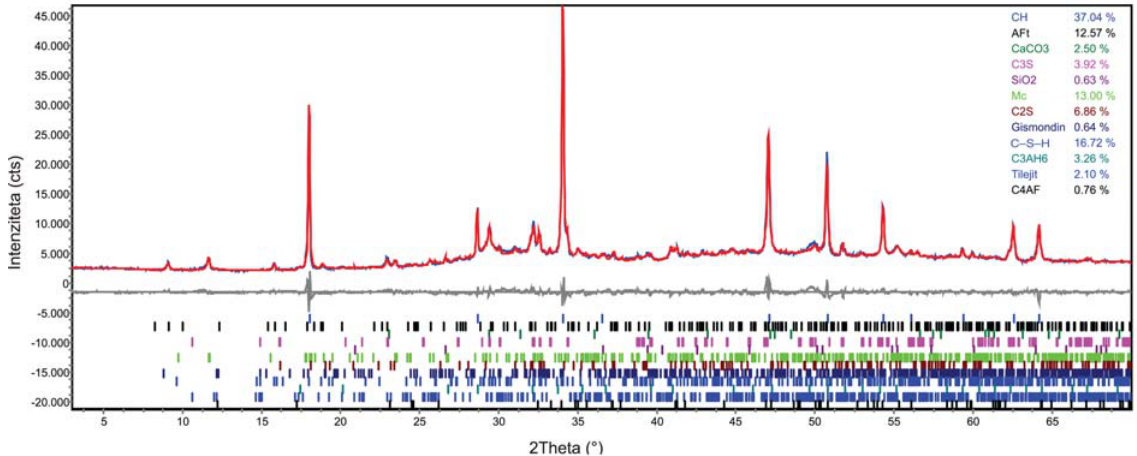
Figure 1. The Rietveld plot of PC, hydrated 90 days. Blue is the measured pattern, red is calculated and grey in the middle is the difference. The vertical bars below denote reflection positions of the included